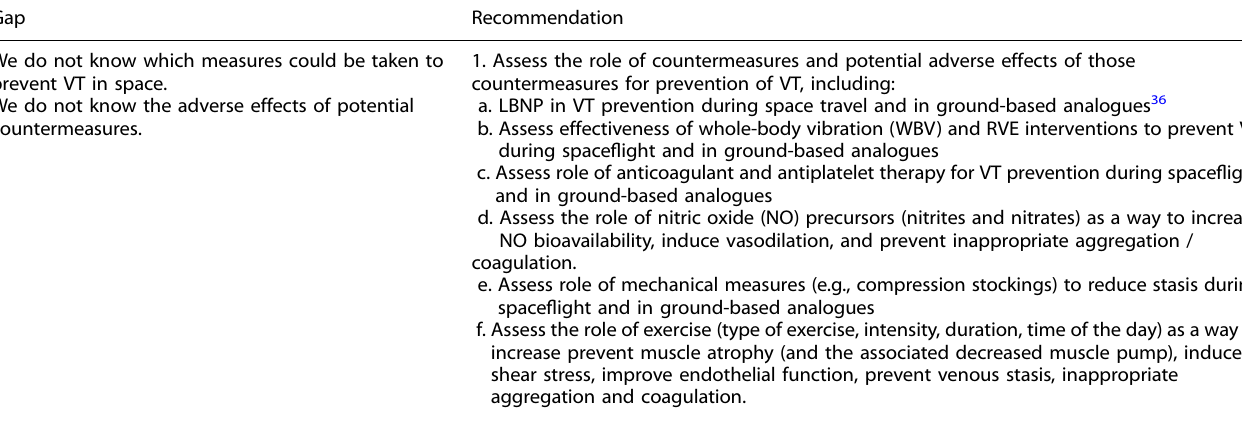
Table 3. Prevention — Gap Analysis and Recommendations. Gap